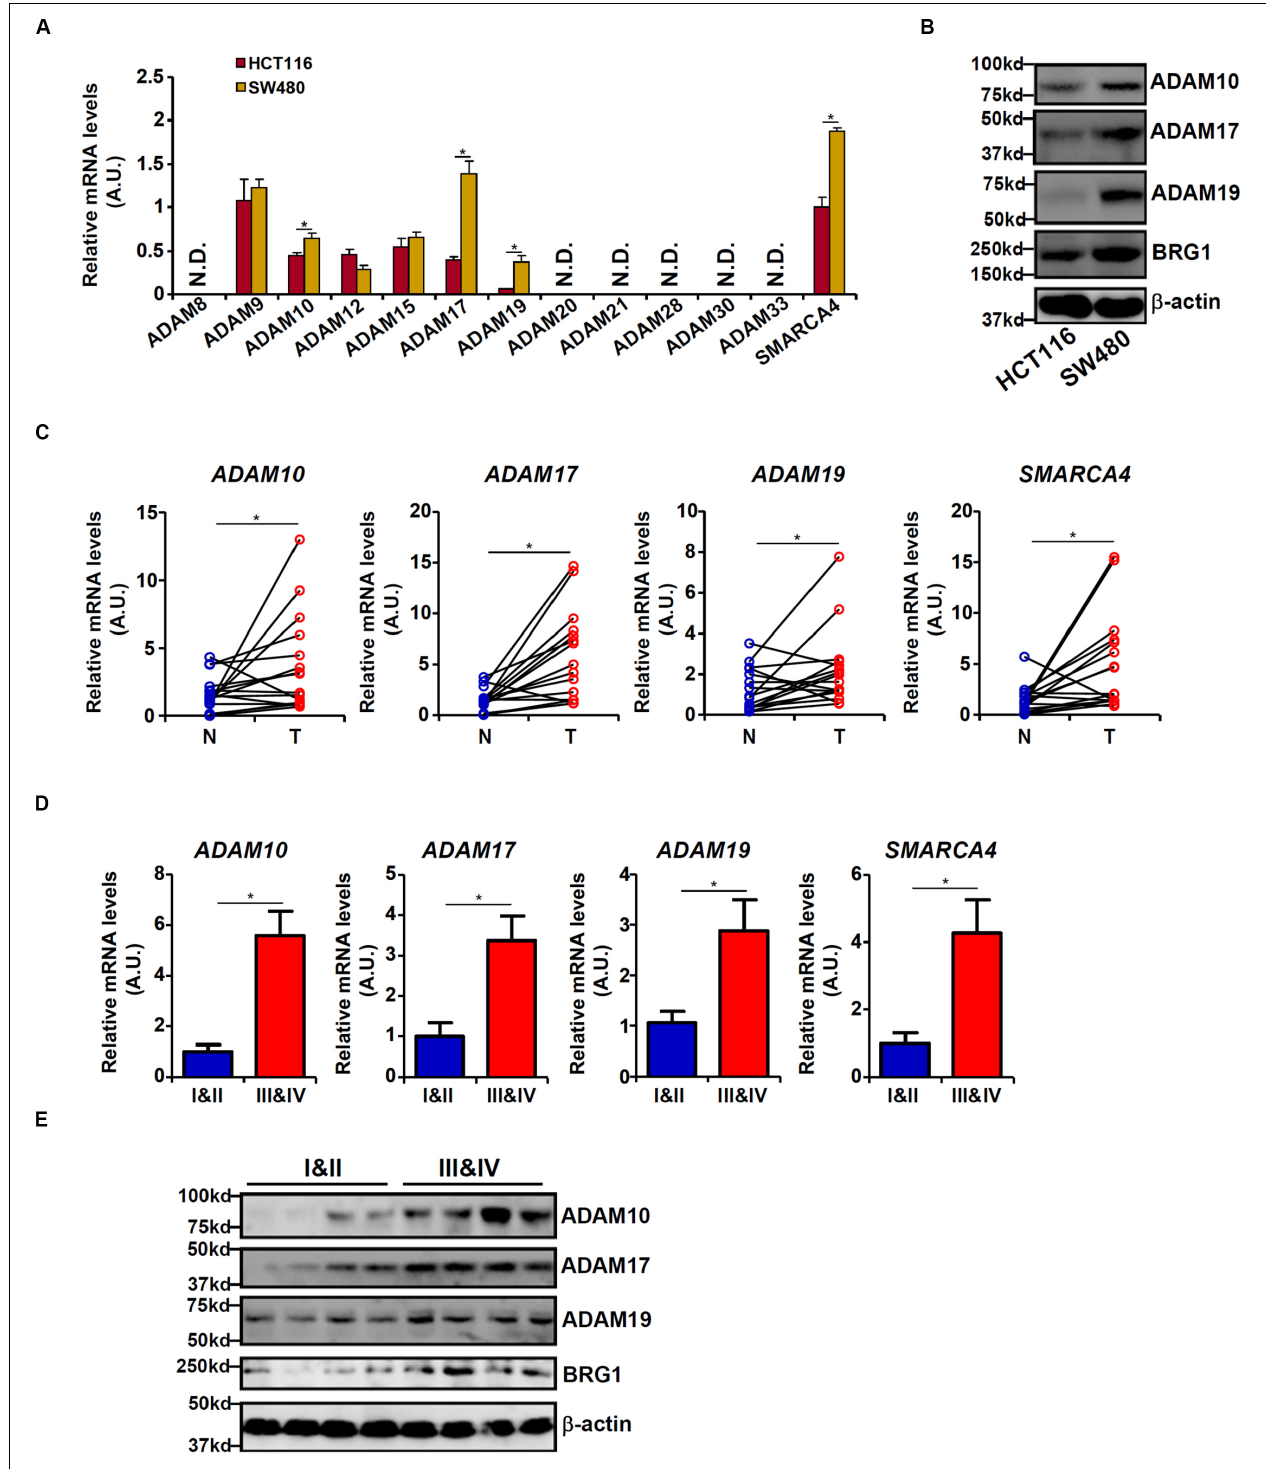
FIGURE 1 | Differential ADAM expression correlates with colorectal cancer (CRC) cell malignancy. (A,B) Expression levels of ADAMs in SW480 cells and HCT116 cells were examined by qPCR and Western blot. (C) ADAM expression levels in human CRC biopsy (T) and paired non-tumorous (N) specimens were examined by qPCR. N = 14 cases. (D,E) ADAM expression levels in human CRC biopsy specimens of different grades were examined by qPCR and Western. N = 5 cases for each group. Data represent averages of three independent experiments, and error bars represent SEM ( p < 0.05, two-tailed Student t test).